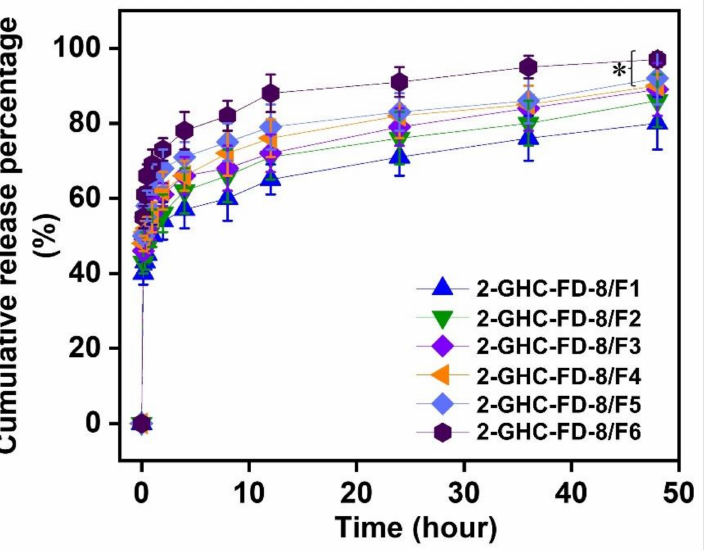
Figure 9. Cumulative release percentage of FGF-7 in 2-GHC-FD-8/F1-6 measured at 37 ◦ C for 48 h. The test was performed five times. The statistical significance was indicated by an asterisk (*) for p < 0.05. At 48 h, 2-GHC-FD-8/F5-6 has significant differences as compared to 2-GHC-FD-8/F1. This type of result is involved in continuous